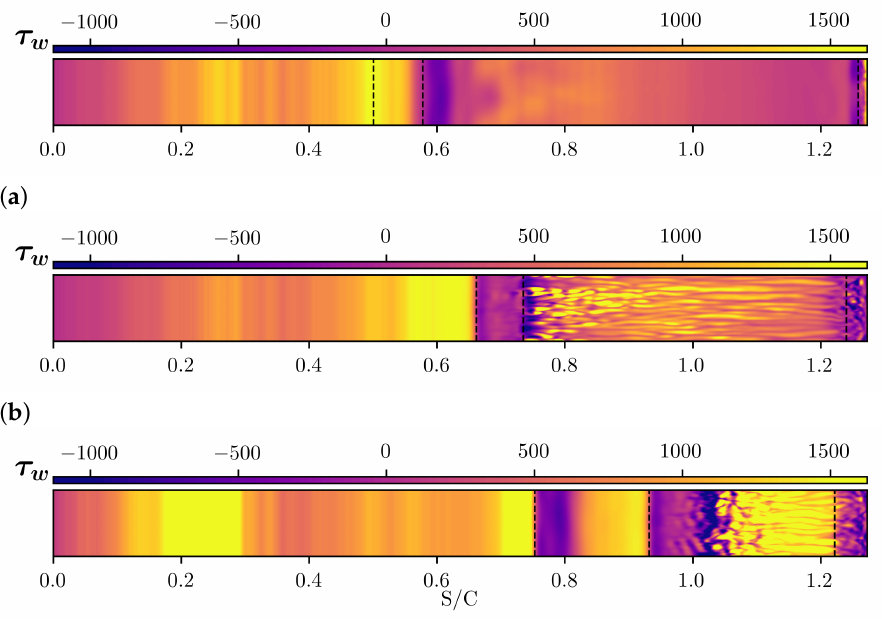
Figure 10. Instantaneous isocontours of the wall shear stress (Pa) for cases IC1-LPR ( a ), IC1-HPR ( b ), and IC2-LPR ( c ). Vertical dashed lines highlight the locations mentioned in the text.